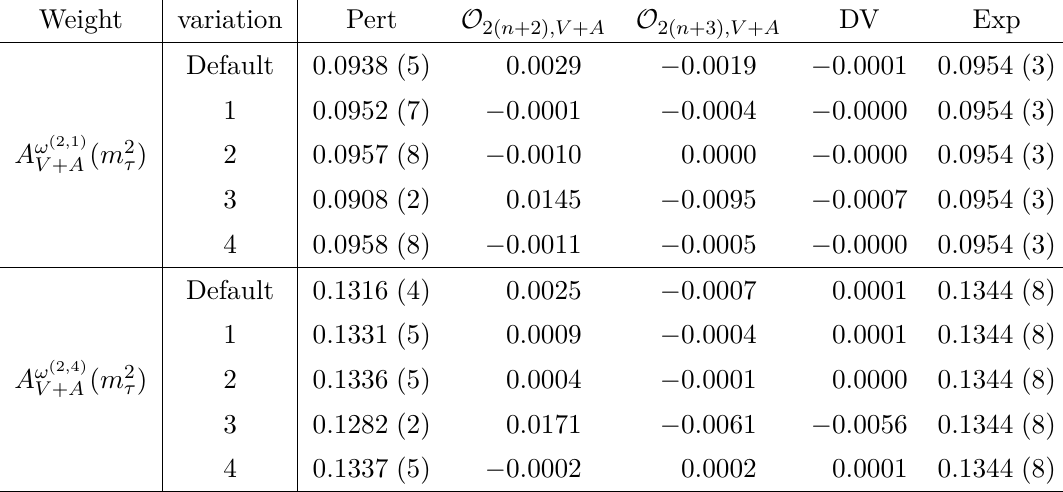
( m 2 ) with n = 1 , 4 , together with their τ V + A